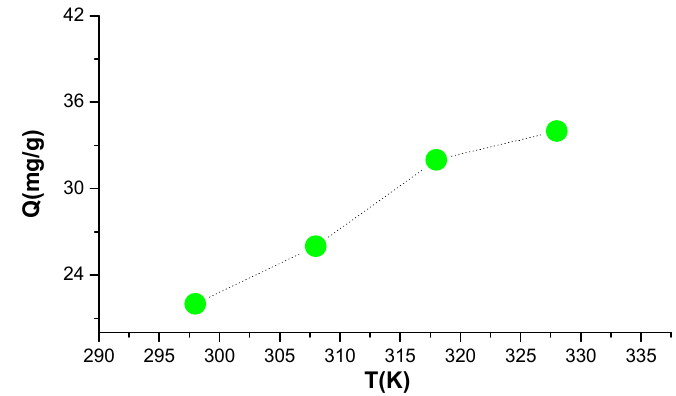
Figure 4. Impact of temperatures on the MG adsorption using AP.